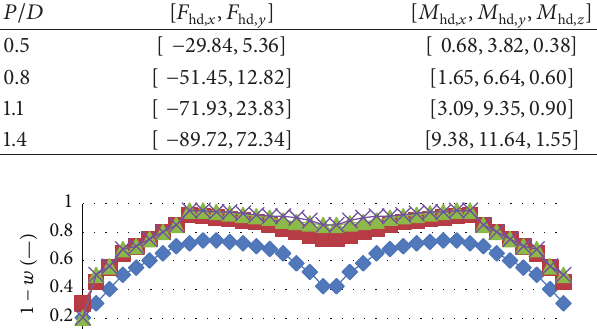
Table 2: Hydrodynamic forces of the investigated propeller.